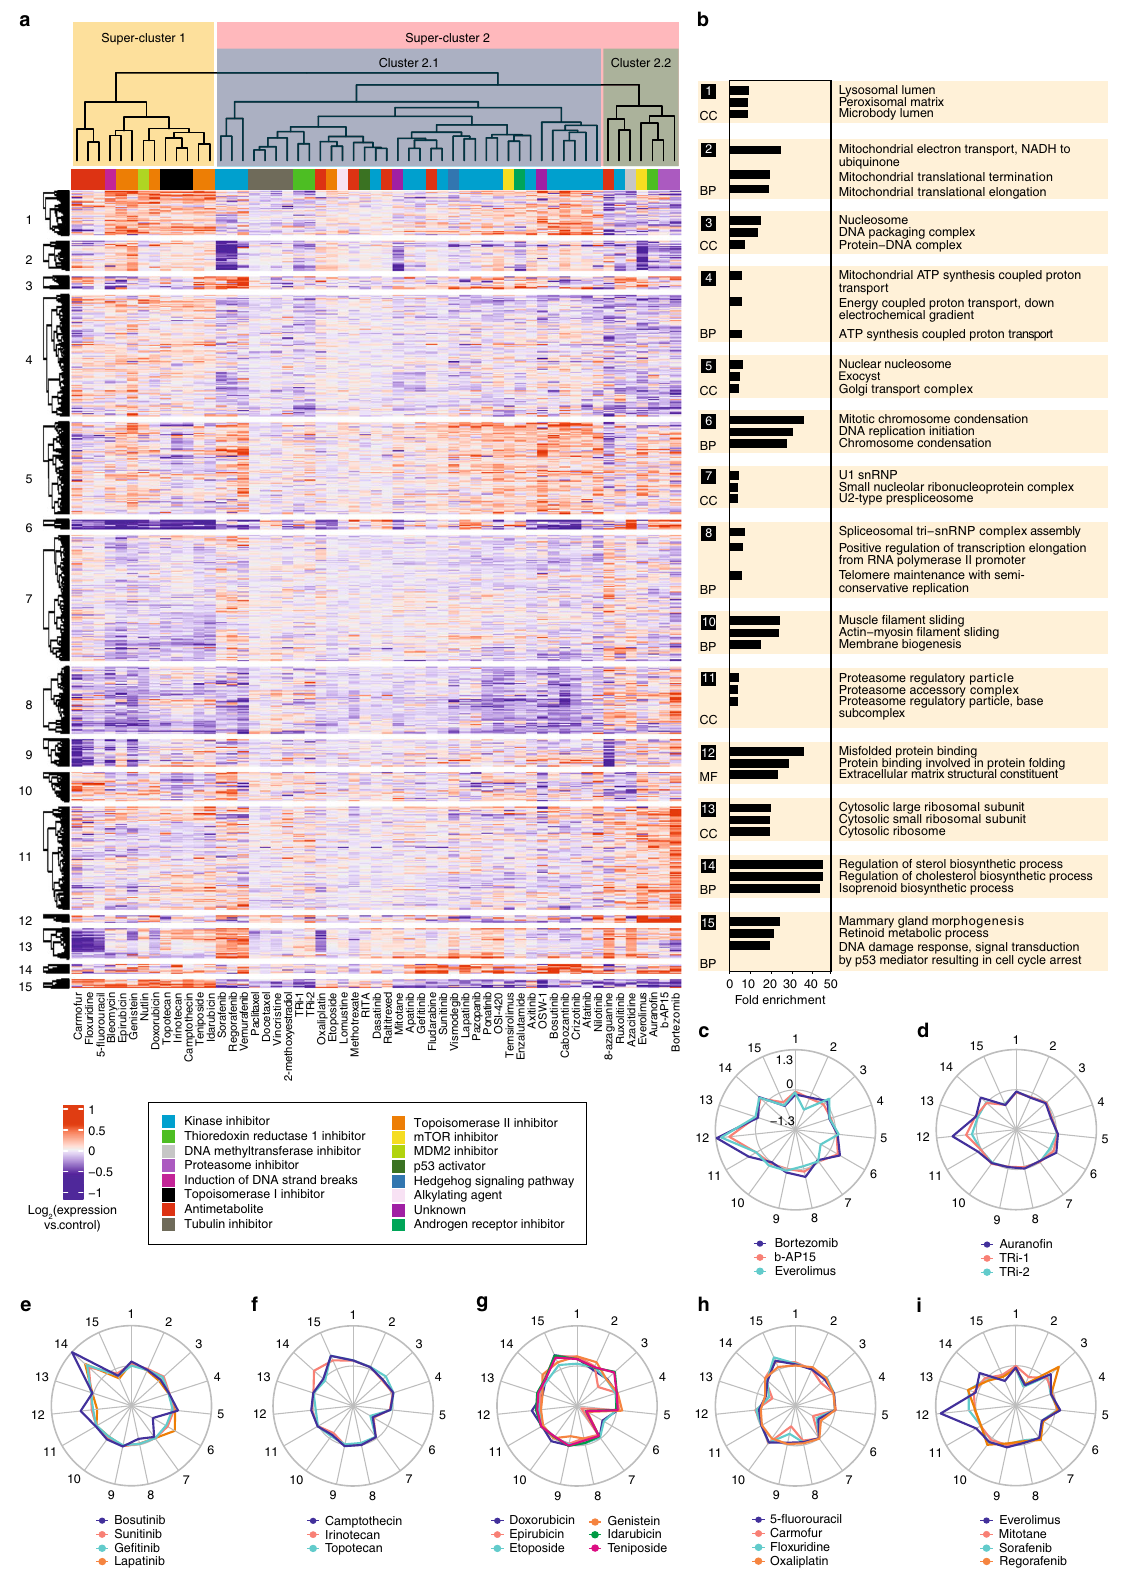
Fig. 2 Hierarchical clustering of the proteome signatures by compounds and proteins. a compound clustering is largely consistent with their presumed MOAs (compound classes are denoted by colors). b top three most enriched gene ontology terms, representing either molecular function (MF), biological process (BP), or cellular component (CC). Cluster 9 that did not map to any speci fi c GO term is omitted. c – i radar plots showing the clusters targeted by representative compounds. The distance from the center is proportional to the mean logarithm of fold change, and inner circle represents zero regulation. Panel a was made from Supplementary Data 1. Source data are provided as a Source Data fi